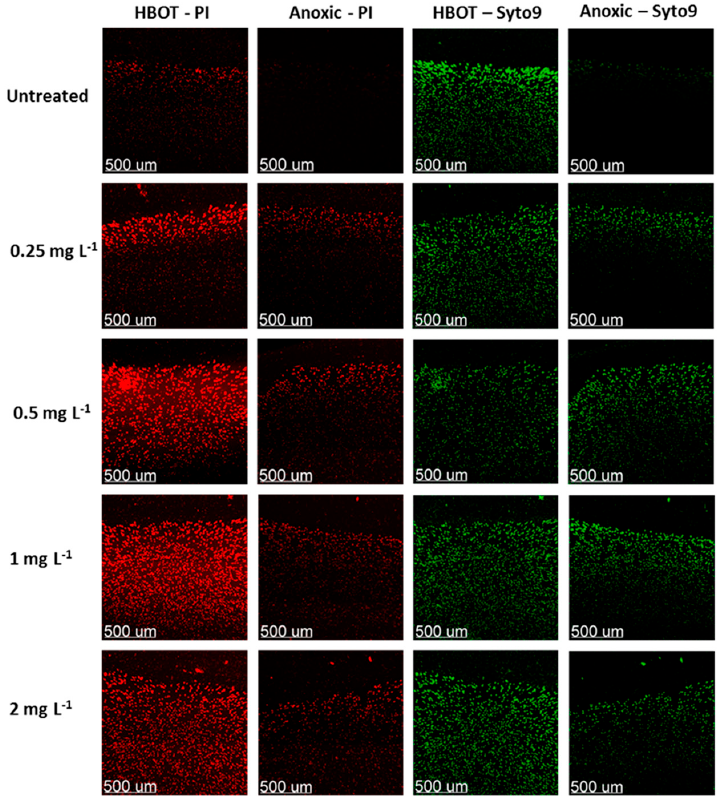
Figure 4. Lethality of a ciprofloxacin-treated P. aeruginosa biofilm during anoxic or Hyperbaric O 2 treatment (HBOT) conditions. Dead or dying cells where stained red with Ppropidium iodide (PI) and live cells where stained green with SYTO9.